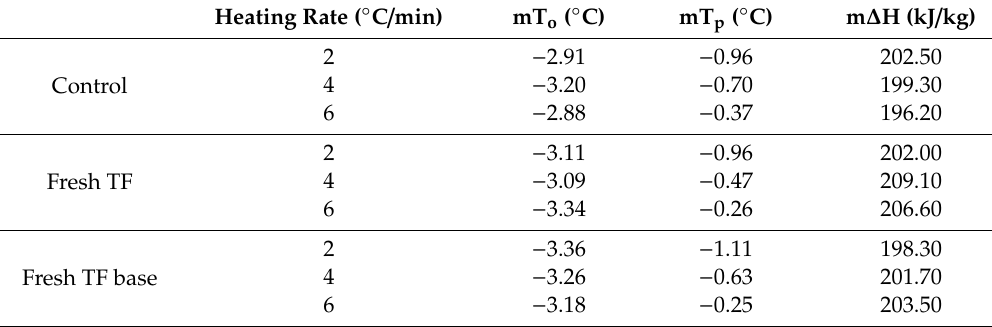
Table 3. Results of DSC tests of ice cream with heating rates of 2, 4, and 6 ◦ C / min over the range of temperatures from − 60 to 30 ◦